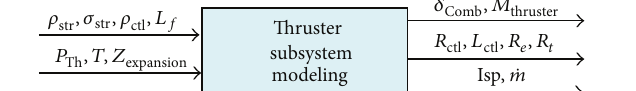
Figure 7: Geometry parameters of the nozzle.